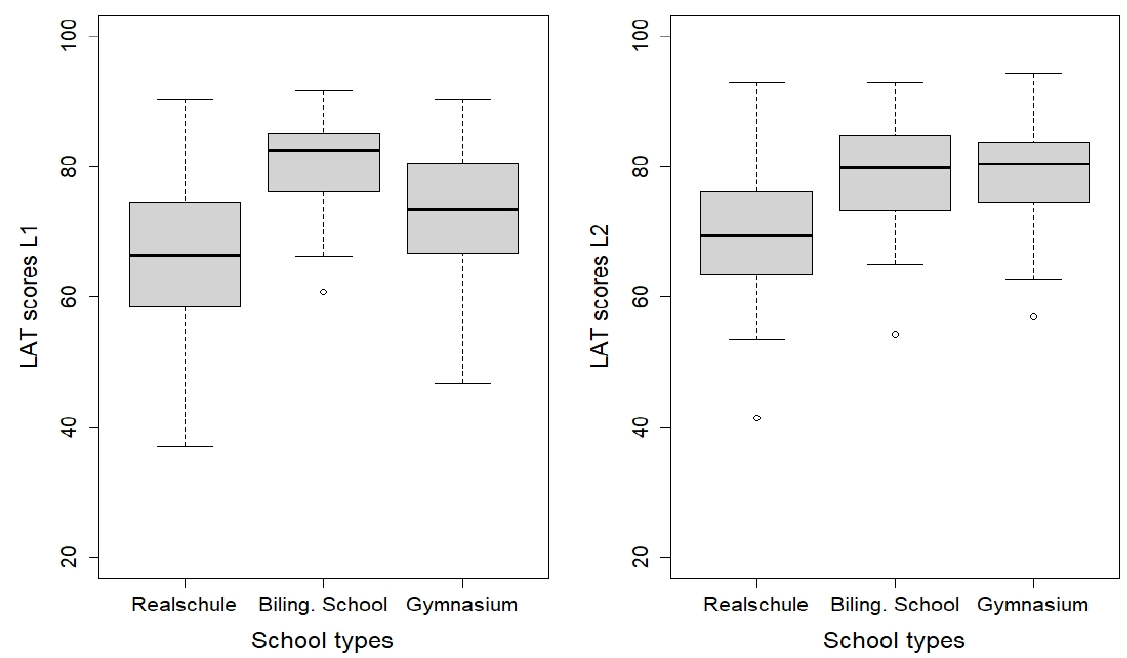
Figure 7. LAT scores in L1 and L2 across school types.